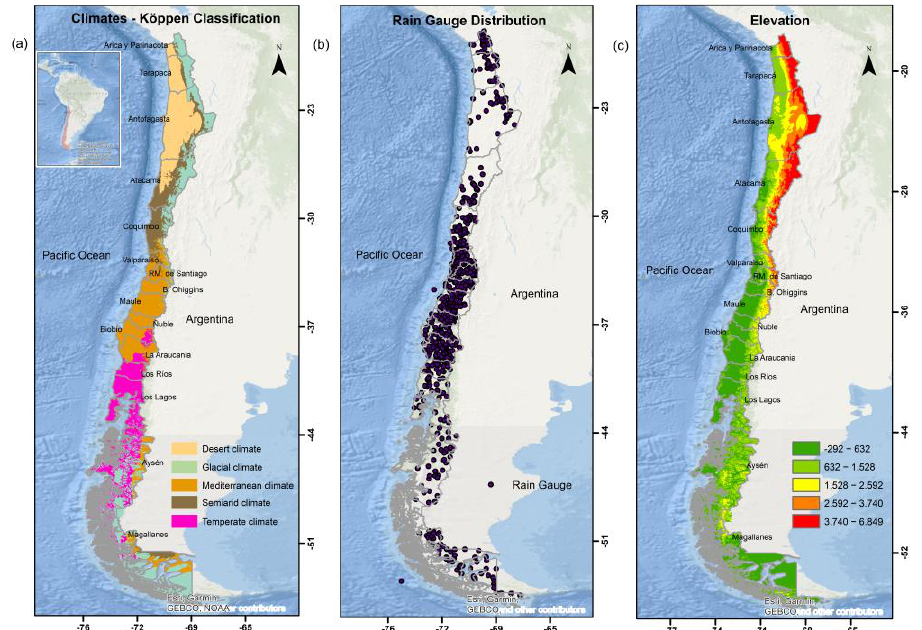
Figure 1. ( a ) Map of Köppen-Geiger climate classifications by color (based on temperature and precipitation), including political and administrative distribution, ( b ) location of rainfall gauge stations across Chilean territory, and ( c ) elevation over Chile. The elevation and distribution of the region were created using an ArcGIS analysis of a shapefile. The shapefiles of Chile and profile elevation were obtained from IDE, https://www.ide.cl/ (accessed on 4 December 2022) [38].